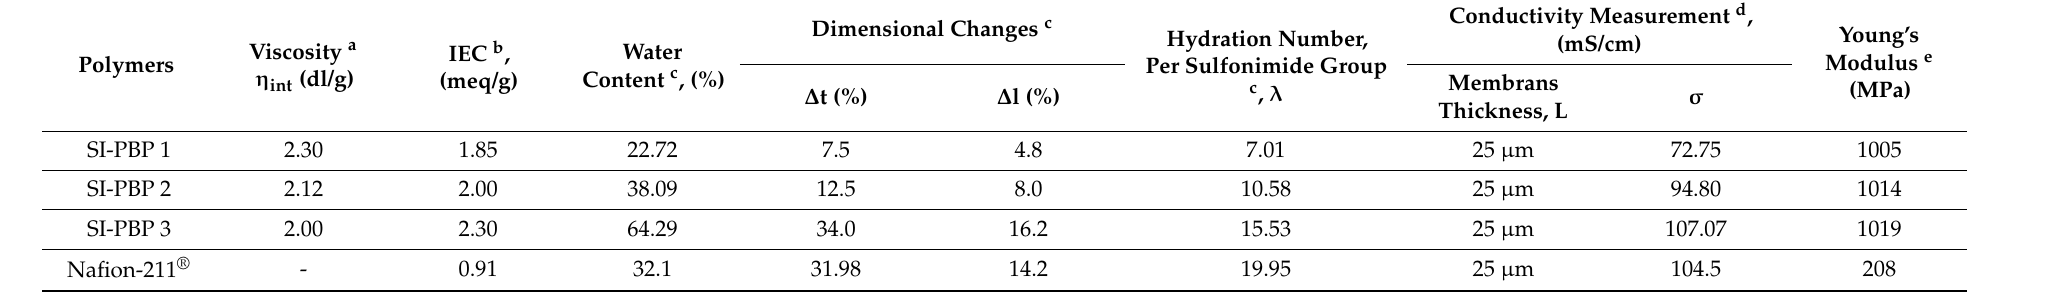
Table 1. Properties of